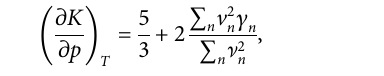
Frontiers in Materials |